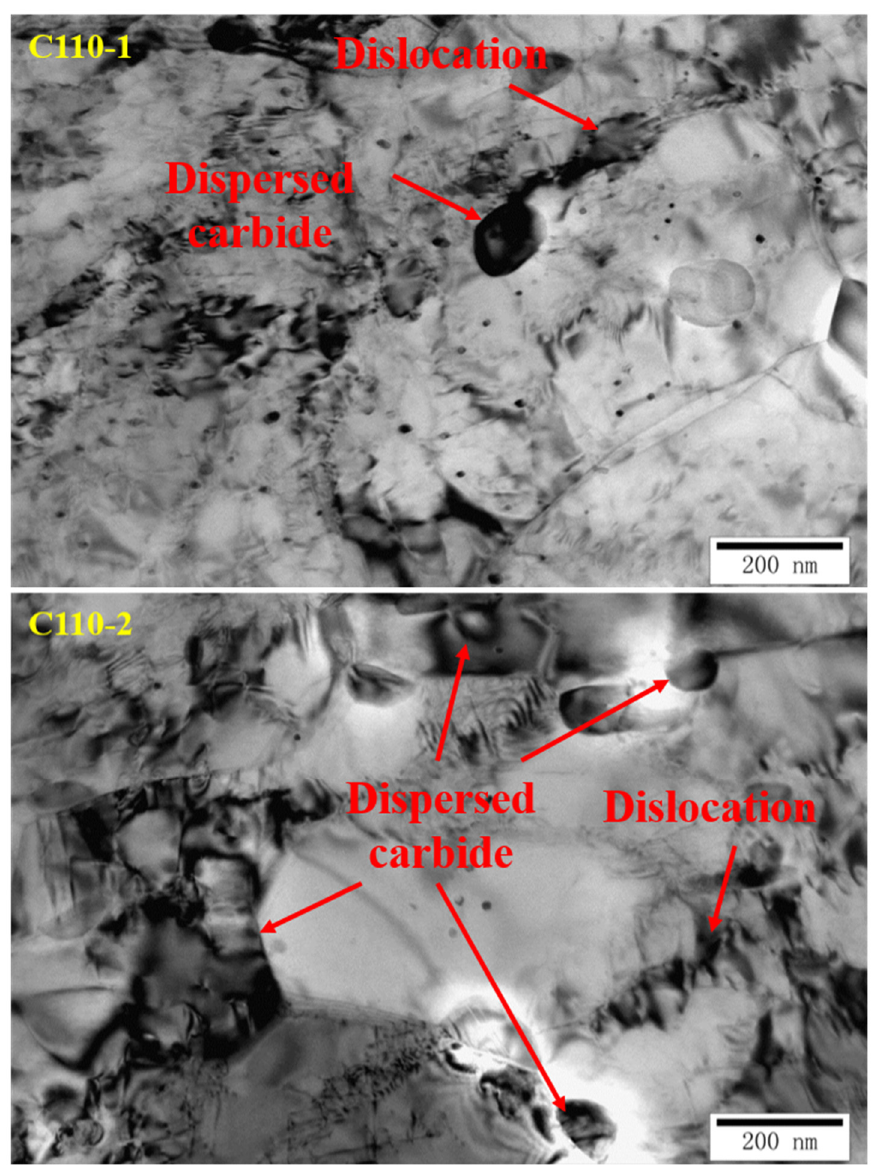
Figure 12. Submicroscopic structure of C110-1 and C110-2.